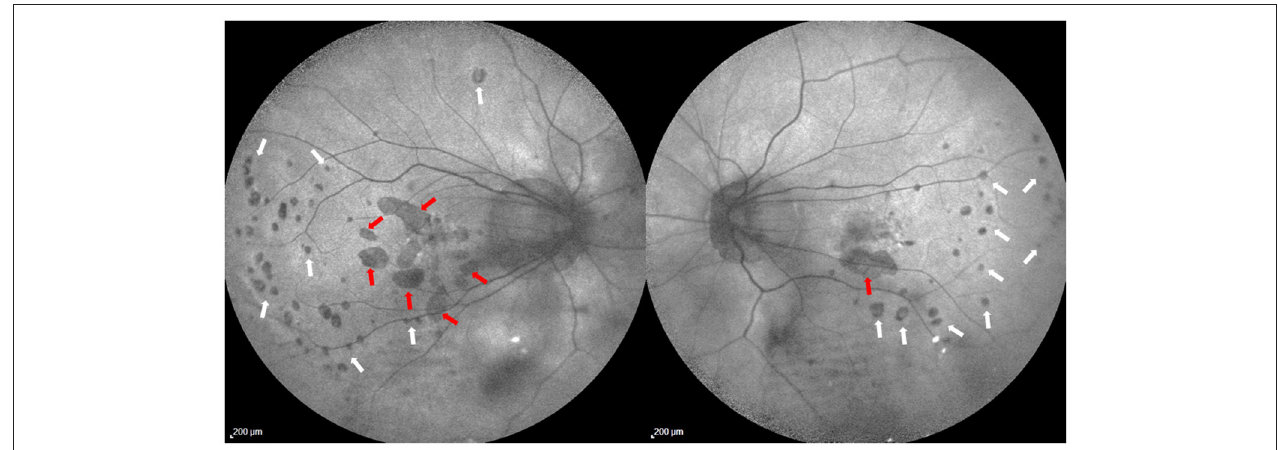
FIGURE 9 | Fundus autofluorescence images in a 46-year-old female with high myopia and history of multifocal choroiditis. Two different atrophic patterns can be identified: patchy chorioretinal atrophic lesions (red arrows) are related to pathologic myopia and located within the posterior pole and the peripapillary area; small rounded hypoautofluorescent spots (white arrowheads) are related to atrophic multifocal changes due to multifocal choroditis, and a faint hyperautofluorescence (unmasking effect) can be observed surrounding these lesions in both eyes. A typical curvilinear distribution of these hypoautofluorescent spots is evident in the temporal region of both eyes.